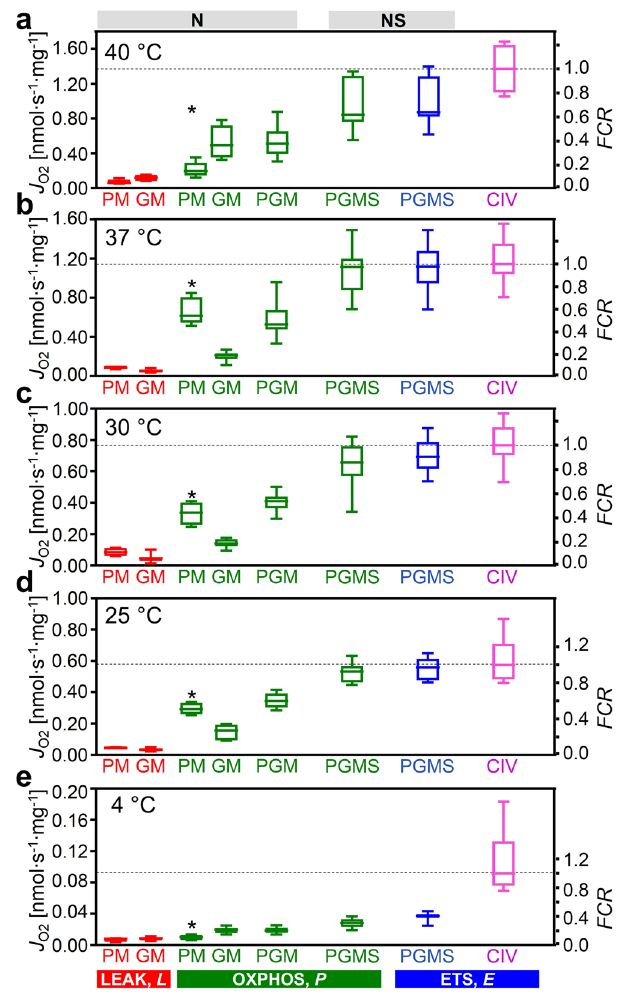
Figure 3. Respiration of permeabilized cardiac fibers ( J O2 , per wet weight), and flux control ratios, FCR , normalized for CIV activity at different temperatures. N L and N P with PM (SUIT 1; n = 4–7) or GM (SUIT 2; n = 5–16); N P with PGM, NS P and NS E with PGMS (both protocols combined; n = 9–23); normalized relative to median CIV E ( n = 4–16). * Significant differences between the two SUIT protocols for the same state. For box plots and abbreviations see Figs 1 and